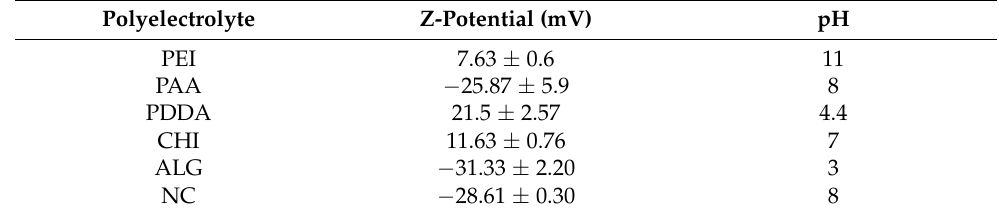
Table 2. Z-potential of the various polymer solutions under specific pH